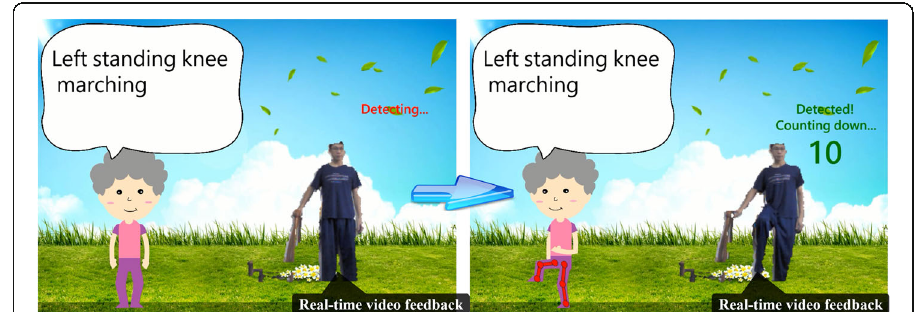
Fig. 7 The real-time feedback given by EverGreen